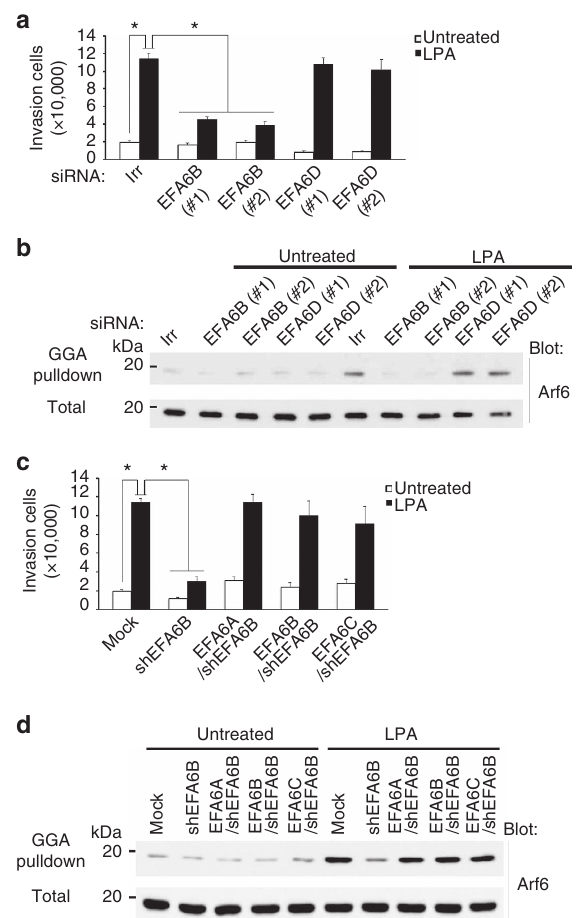
Figure 4 | Involvement of EFA6A-C but not EFA6D in LPA-induced invasion and Arf6 activation of 786-O cells. ( a , b ) Requirement for endogenous EFA6B, but not endogenous EFA6D, in LPA-induced Matrigel invasion ( a ) and Arf6 activation ( b ), as assessed by their gene silencing using specific siRNAs, as indicated. ( c , d ) EFA6A and EFA6C, expressed in 786-O cells instead of the endogenous EFA6B (EFA6A/shEFA6B cells and EFA6C/shEFA6B cells, respectively) promoted Matrigel invasion ( c ) and Arf6 activation ( d ) in response to LPA. shEFA6B cells and